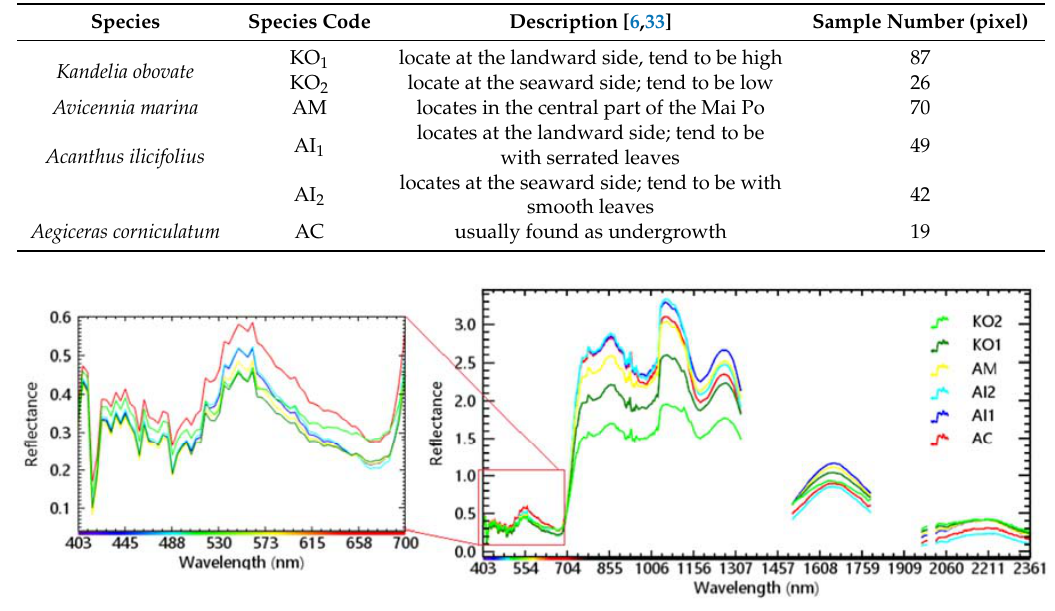
Figure 2. The mean reflectance spectra of six mangrove species (the scale was set to be 10 for demonstration).